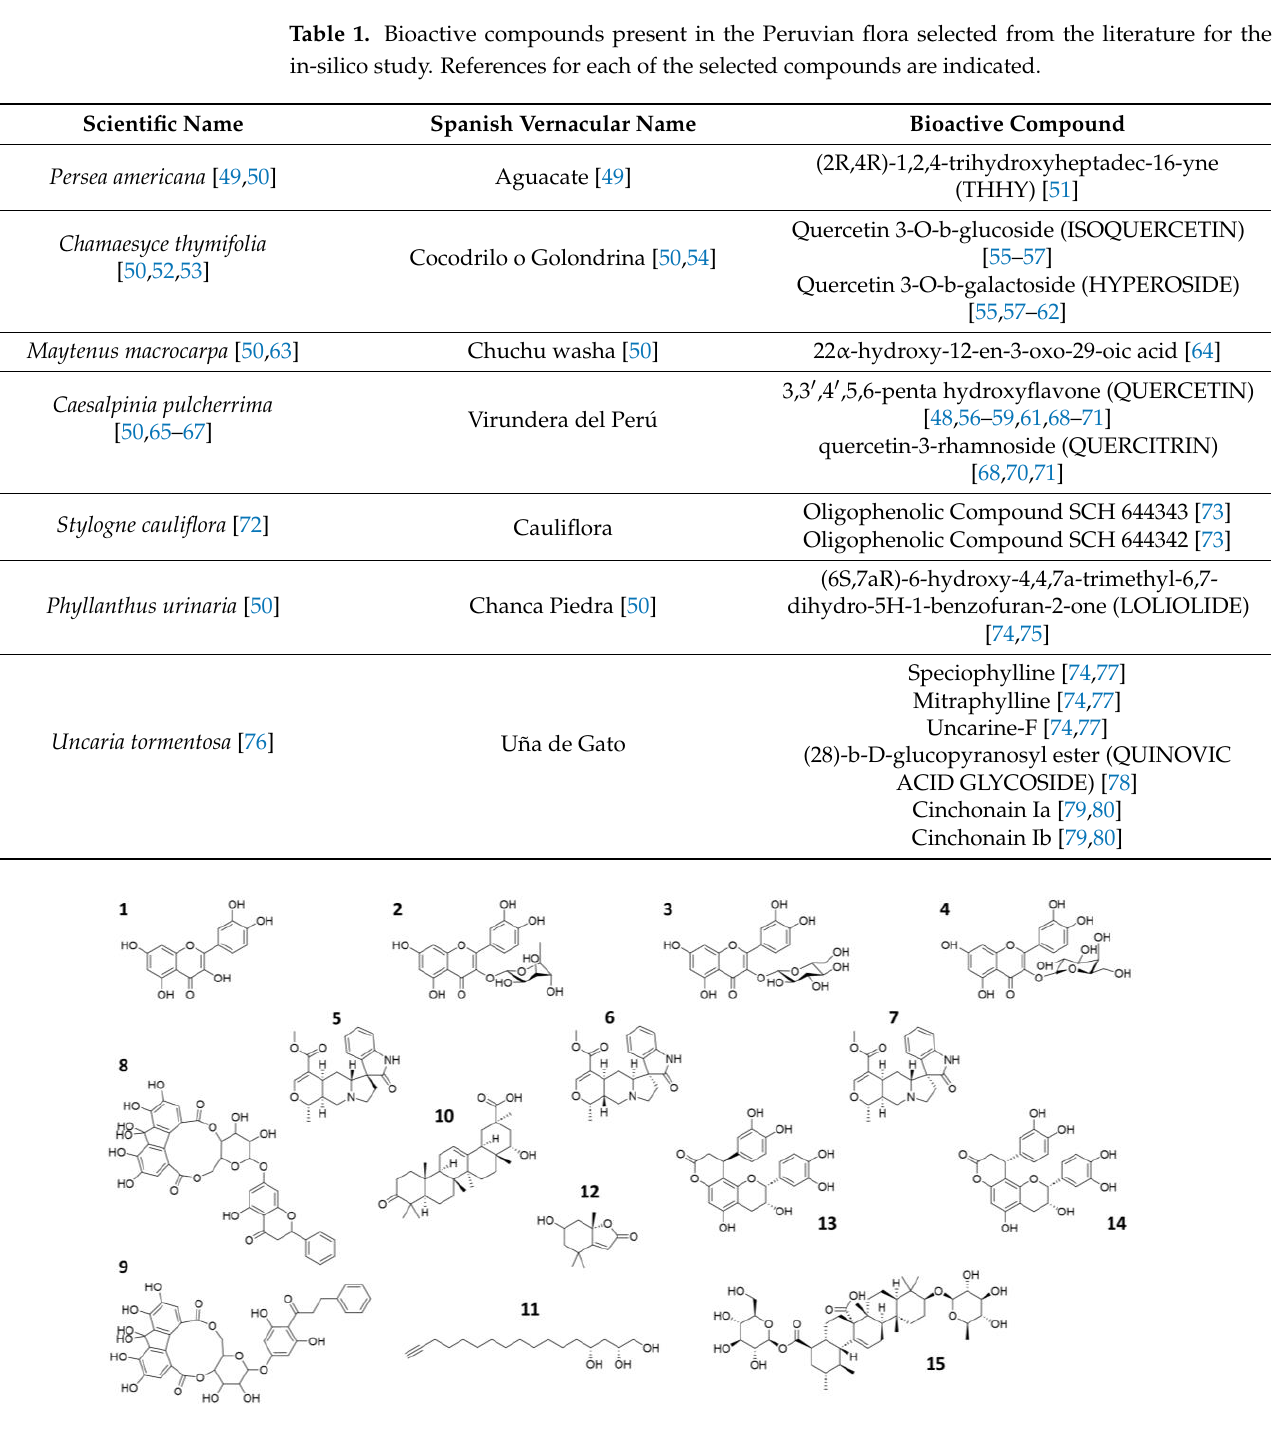
Figure 1. 2D representation of the natural compounds selected for the present in silico study. Quercetin ( 1 ), Quercitrin ( 2 ), Isoquercetin ( 3 ), Hyperoside ( 4 ), Speciophylline ( 5 ), Mitraphylline ( 6 ), Uncarine—F ( 7 ), oligophenolic compound SCH 644343 ( 8 ), oligophenolic compound SCH 644342 ( 9 ), 22α-hydroxy-12-en-3-oxo-29-oic acid ( 10 ), (2R,4R)-1,2,4-trihydroxyheptadec-16-yne ( 11 ), (6S,7aR)-6-hydroxy-4,4,7a-trimethyl-6,7-dihydro-5H-1-benzofuran-2-one ( 12 ), Cinchonain Ia ( 13 ), Cinchonain Ib ( 14 ) and (28)-b-D-glucopyranosyl ester ( 15 ). Table 1. Bioactive compounds present in the Peruvian flora selected from the literature for the in- silico study. References for each of the selected compounds are indicated.